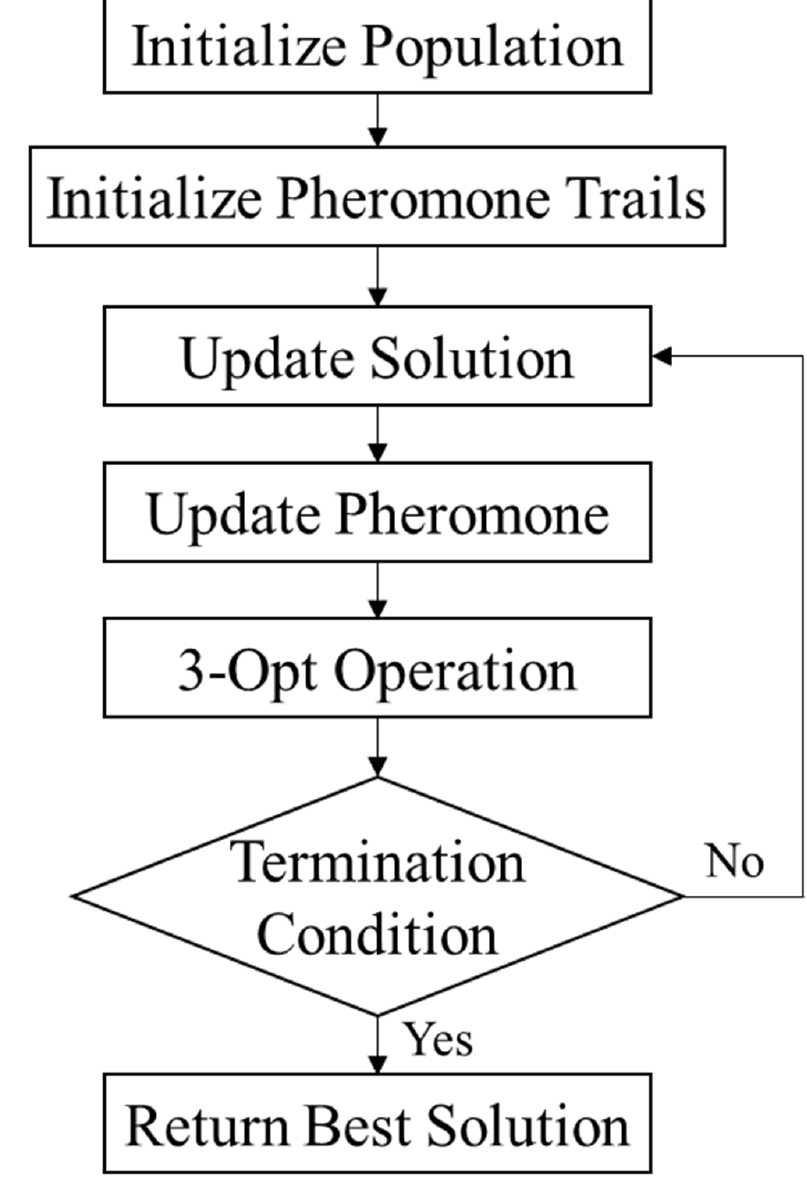
Figure 3. The flowchart of the proposed method.